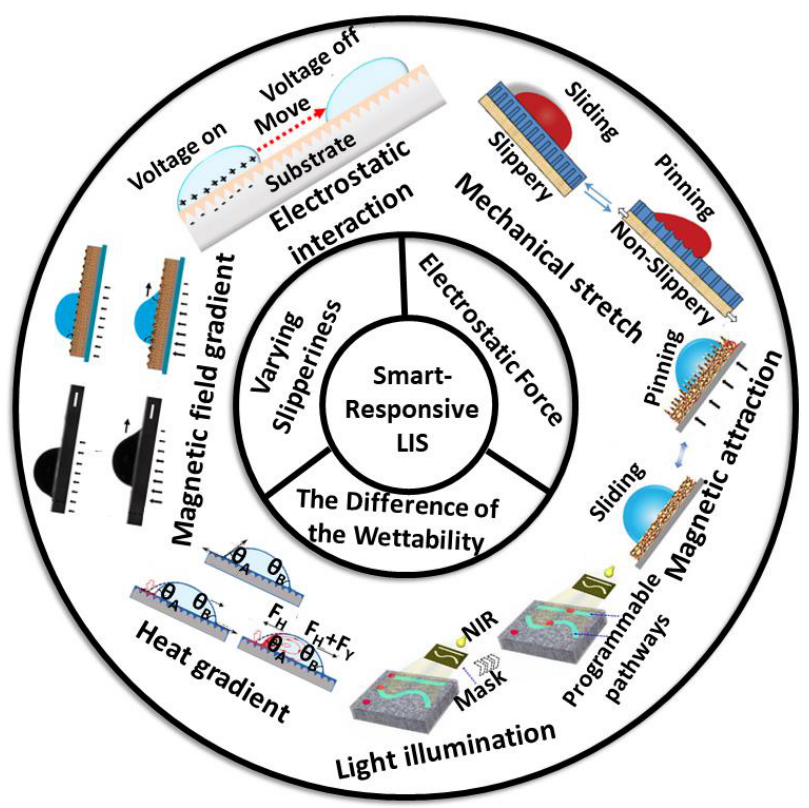
Figure 1. Overview of the droplet manipulation on a smart lubricant-infused surface (LIS).